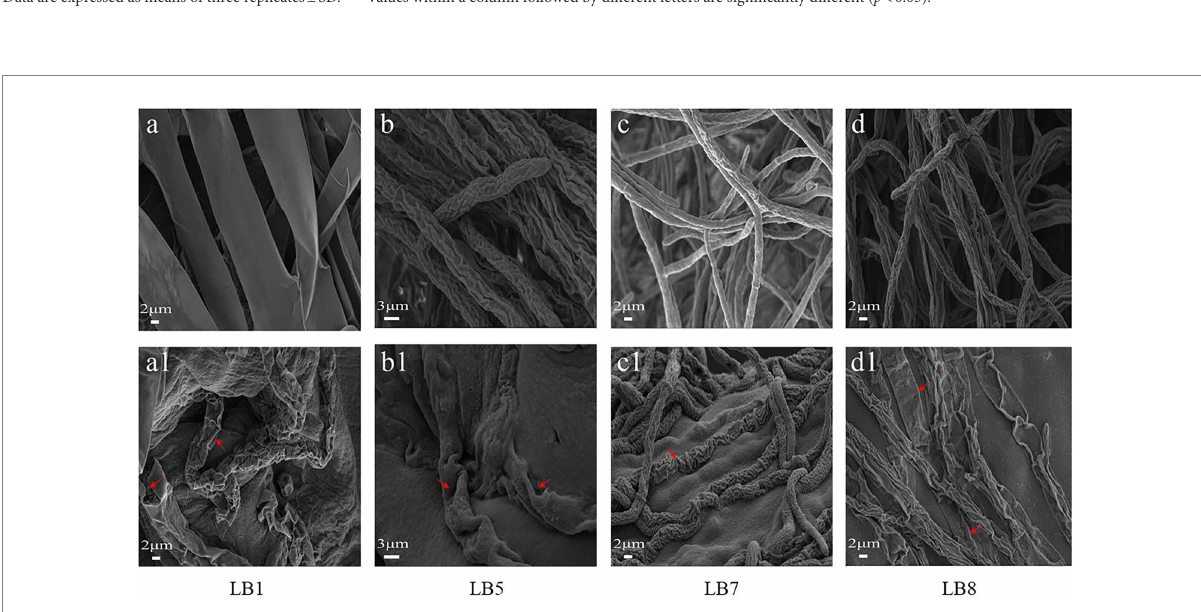
pathogenic fungus LB8 were severely distorted and appeared to be severely collapsed and squashed (Figures 3D, D1).